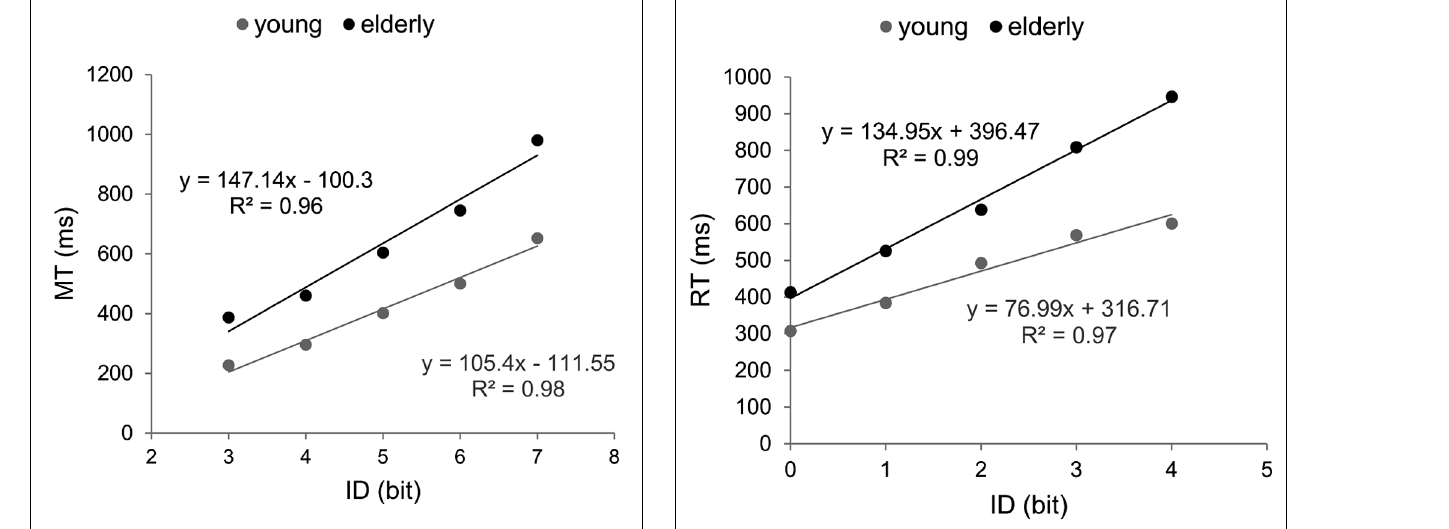
FIGURE 2 | Efficiency functions for reaction time in Hick–Hyman’s task. Young participants’ data and linear regression estimates are presented in gray and those of older participants in